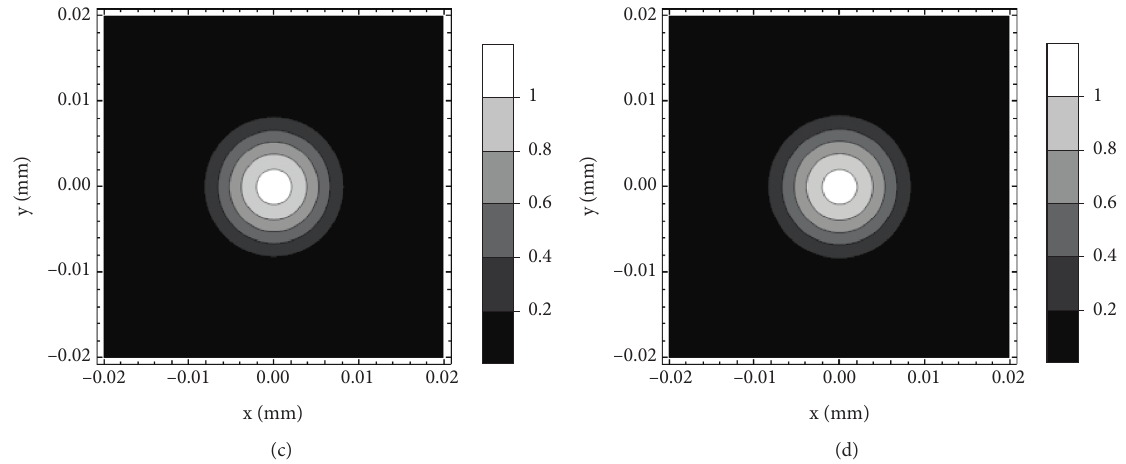
Figure 5: Intensity patterns of the partially coherent Lorentz beam with incident beam widths of w coherence widths σ � 8mm at different propagation distances in along focal length of logarithmic axicon. (a) z � 100mm. (b) z � 140mm. (c) z � 180mm. (d) z � 200mm.